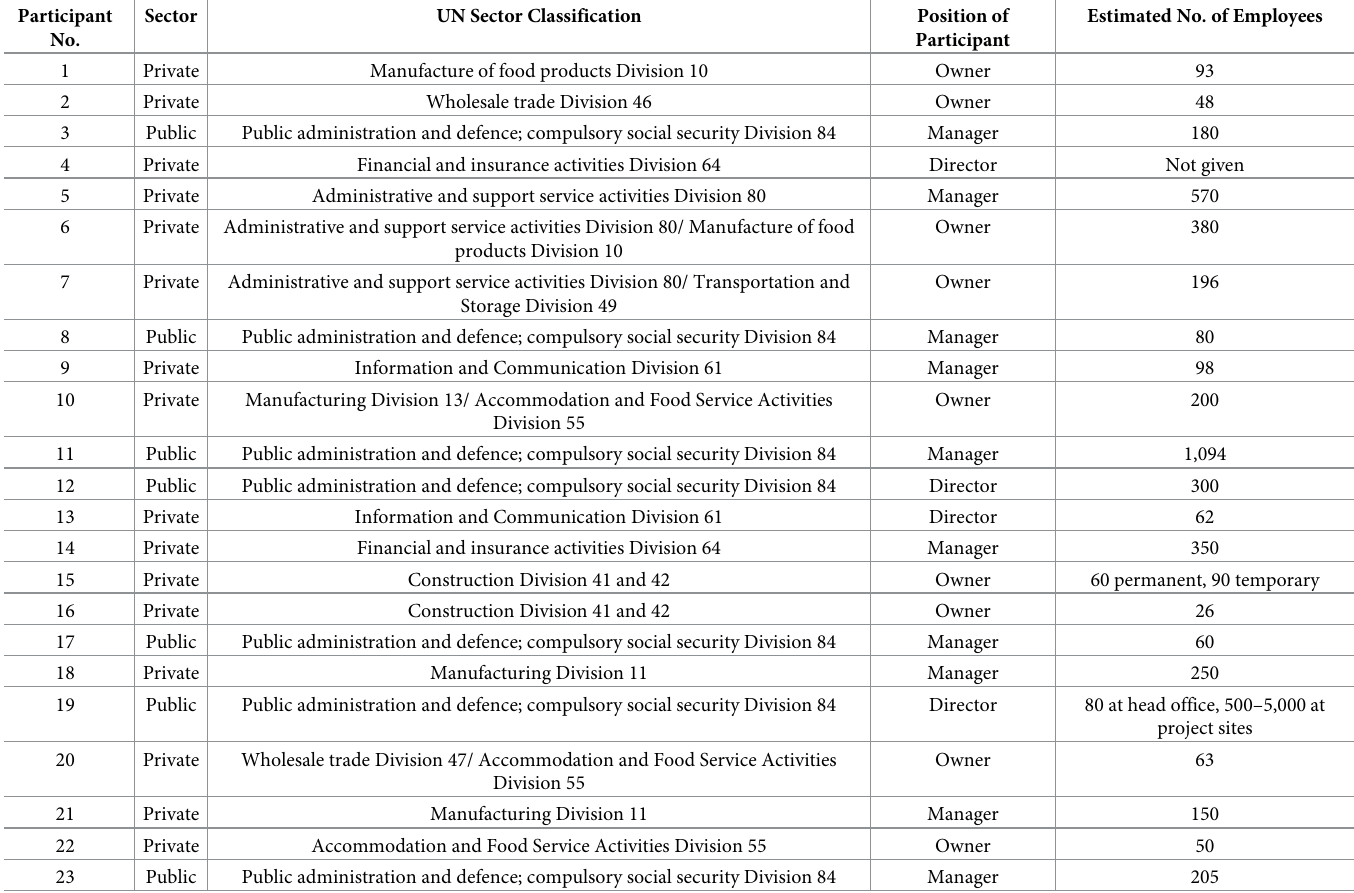
Table 1. Characteristics of organisations in the sample. Participant